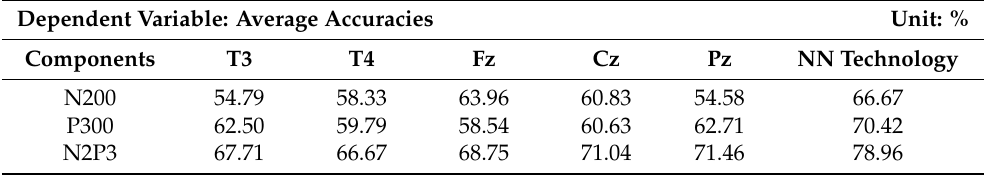
Table 8. Comparison of the average accuracy of three ERP components (N2P3, P300, and N200).